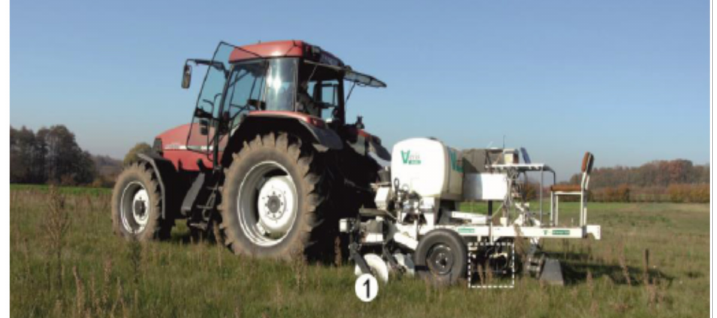
Figure 4. Tractor mounted Veris mobile sensor platform reprinted from ref. [93] for on-the-go soil analysis on grazed